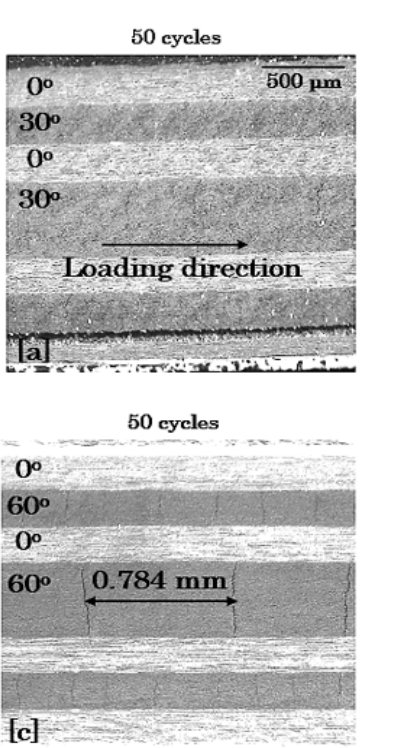
Figure 18. Damage in [0°/30°] 2s (top) and [0°/60°] 2s (bottom) laminates after ( a , c ) 50 and ( b , d ) 200 cycles for σ max = 0.8 × σ ult and R = 0.1.